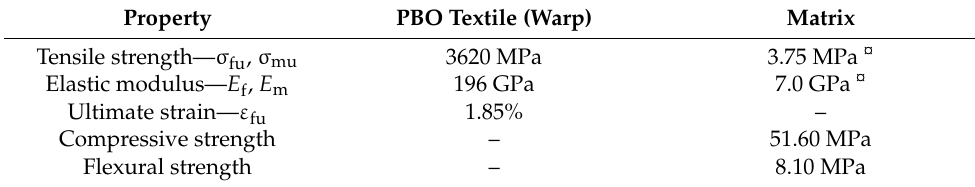
Table 1. Mechanical properties of fiber textile and